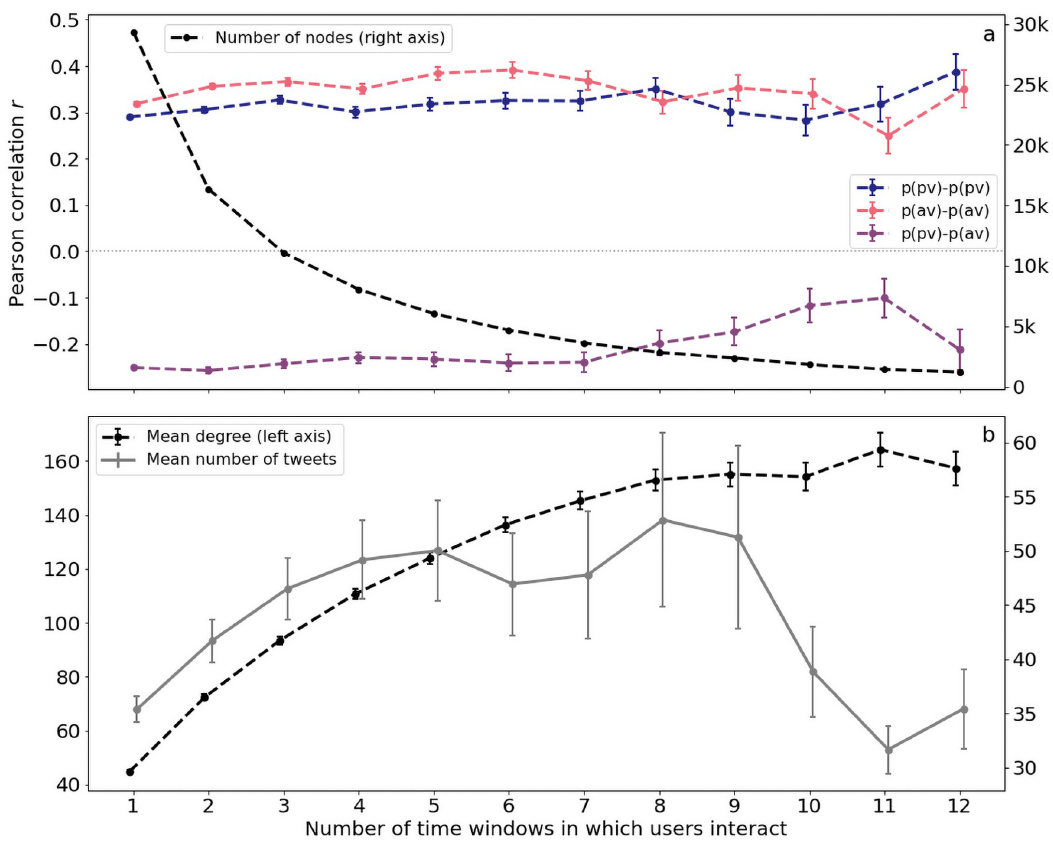
Fig 5. Interplay between average vaccination sentiment and user interactions. a : Users tend to disproportionally interact with users of similar stance, both in cases where users only interact during a single, and multiple, three-month time windows. Specifically, we compute for all users the average probabilities of that user’s tweets expressing pro/anti-vaccine sentiment. Comparing these averages for all nodes and their neighbors, we find a positive correlation between the average pro- and antivaccine sentiments. Similarly, the average pro-vaccine sentiment of nodes exhibits a negative correlation with the anti-vaccine sentiments of their neighbors. The number of nodes in the interaction network decreases exponentially as the minimum number of time windows is increased. The negative correlation between pro- and antivaxx probabilities of neighbors tends slightly toward zero as the threshold for repeated interaction grows. b : As increasingly repeated interactions are considered, users in the interactions graph are increasingly well connected. However, the number of vaccination-related tweets posted by users decreases for interactions occurring very frequently, indicating that at this point, the graph likely includes users who are highly active on Twitter, yet do not discuss vaccination-related topics very often. Error bars on Pearson correlations represent one standard deviation of the Fisher-transformed variables z , i.e. the bounds on the error bar on a correlation r of n data points, is given by tanh( z ± σ ffiffiffiffiffiffiffiffiffiffiffi s ¼ 1 = n (cid:0) 3 z